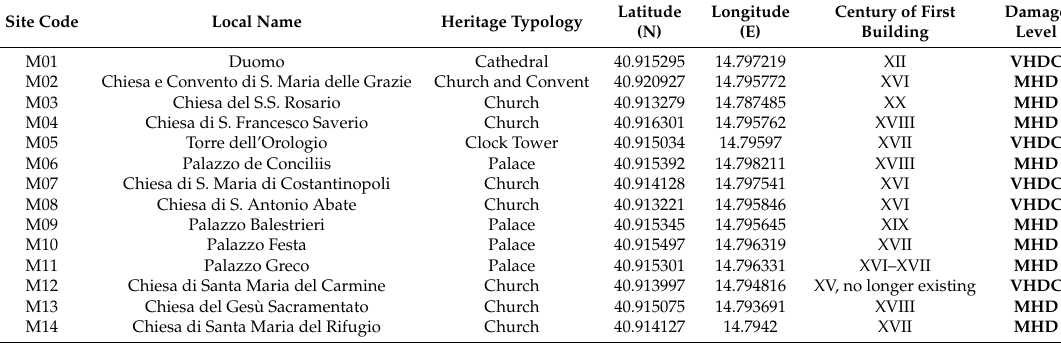
Table 2. The historical monuments of Avellino damaged by the 1980 earthquake with the main information and the level of damage assessed based on bibliographic sources (SLD, Slight Damage; MHD, Moderate to Heavy Damage; VHDC, Very Heavy Damage to